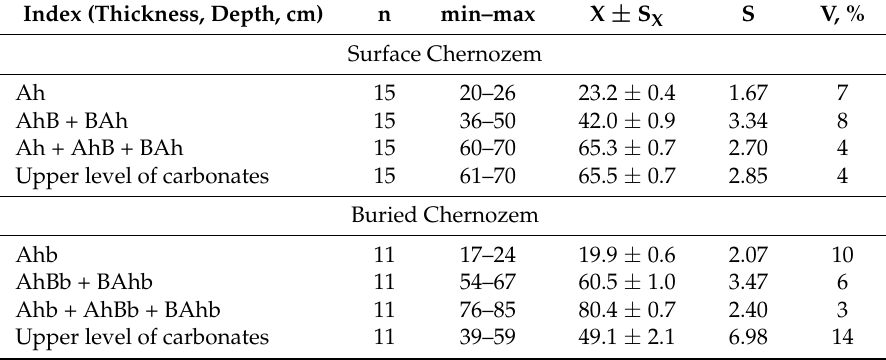
Table 2. Morphometric indexes of surface (modern) and buried under mound of 4600 years BP Chernozems in the Yamskaya steppe